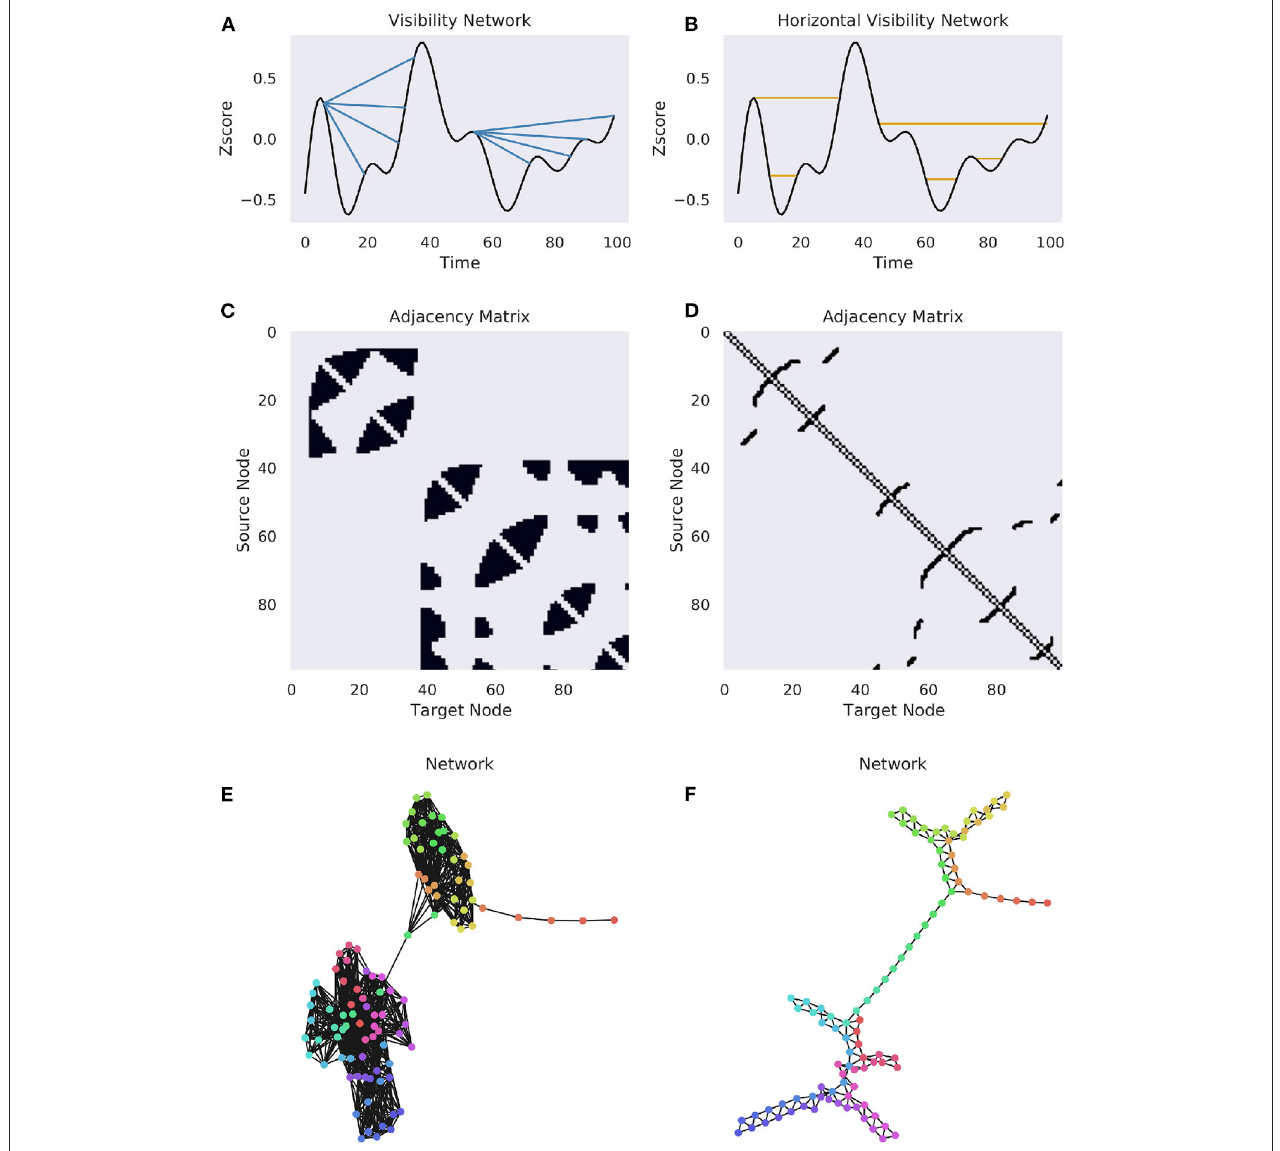
FIGURE 3 | Complete and horizonal visibility networks. A comparison of the VN and HVN networks for the same Human Connectome Project BOLD data (Van Essen et al., 2013). A single time series was selected from a subject at random for demonstration purposes. (A) A cartoon of the visibility graph algorithm. For each origin point, an edge is drawn between it and all the points that it can “see”, illustrated by the multiple blue lines. (B) A cartoon of the horizontal visibility graph, where an edge is only drawn between an origin point at the next point at the same height. (C,D) The binary adjacency matrices for the above univariate time series. (E,F) The networks for the associated binary adjacency matrices. The colors correspond to the flow of time, as in Figure 1